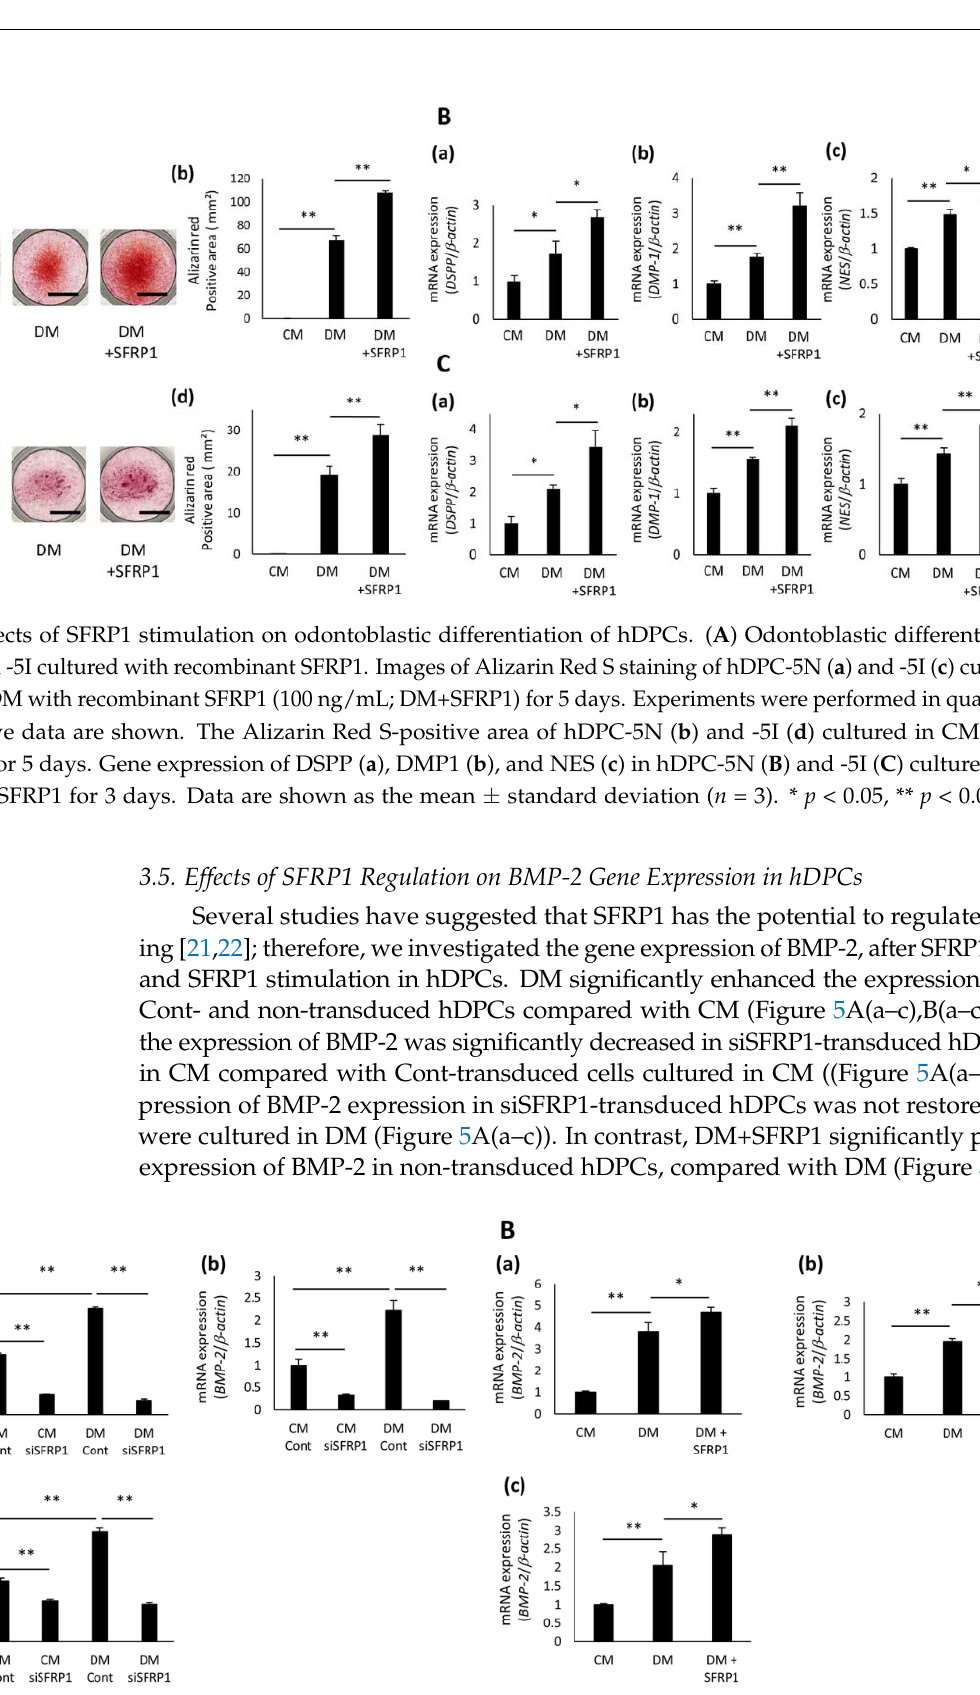
Figure 5. Effects of SFRP1 knockdown and SFRP1 stimulation on BMP-2 gene expression in hDPCs. ( A , B ) Gene expression of BMP-2 in hDPCs. Following the transduction of Cont or siSFRP1, hDPCs were cultured in CM or DM for 2 days ( A ). Non-transduced hDPCs were cultured in CM, DM, or DM+SFRP1 for 3 days ( B ). hDPC-5N ( a ), -5I ( b ), and -3R ( c ) were used in this study. Data are shown as the mean ± standard deviation ( n = 3). * p < 0.05, ** p <